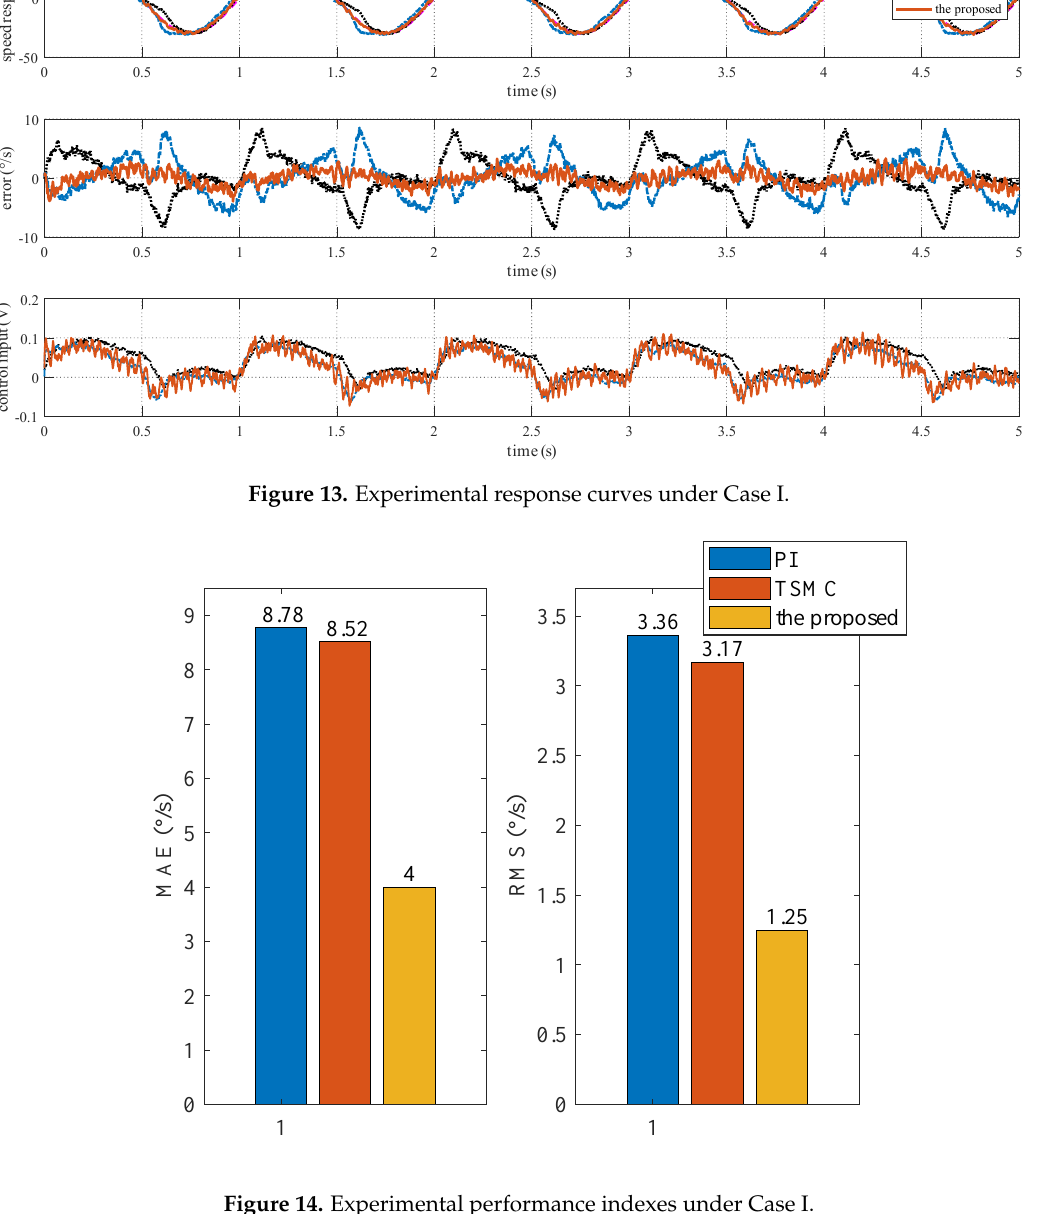
Figure 14. Experimental performance indexes under Case